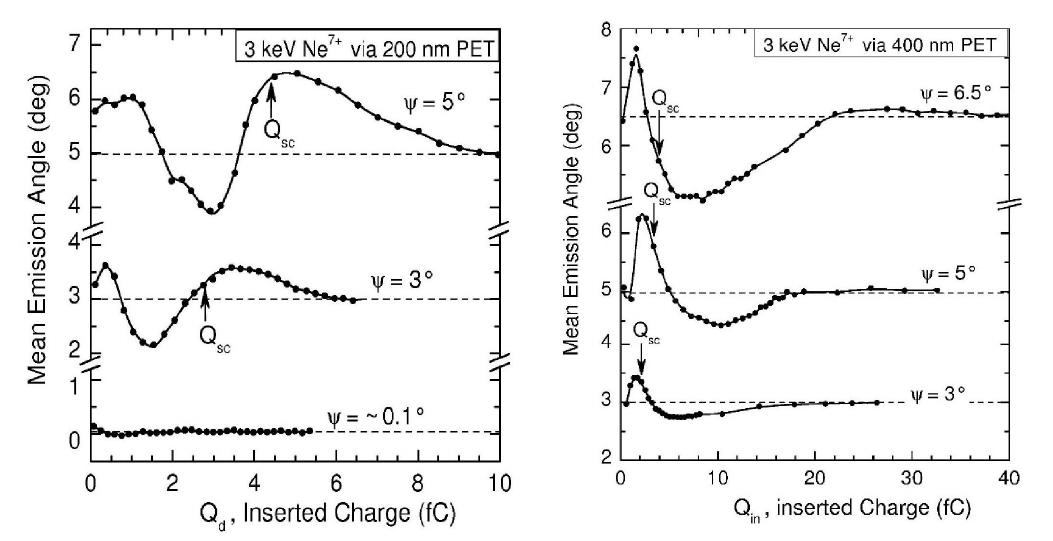
Figure 3. Mean emission angle of the transmitted Ne 7 + ions as a function of the inserted charge Q in for capillaries of different diameter d . [Left] d = 200 nm. The tilt angles are 0 ◦ , 3 ◦ , and 5 ◦ as indicated in the graphs. [Right] d = 400 nm. The tilt angles are 3 ◦ , 5 ◦ , and 6.5 ◦ . The arrows labeled Q sc specify characteristic charges (see text). Data taken from Ref.